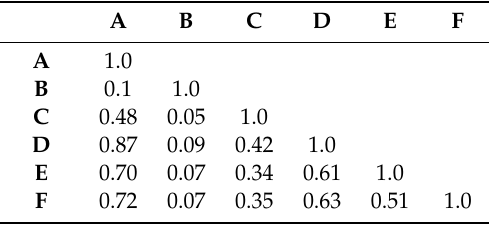
Table 6. The correlation coe ffi cients on fall among the seasonal Weibull distributions of the six farms.